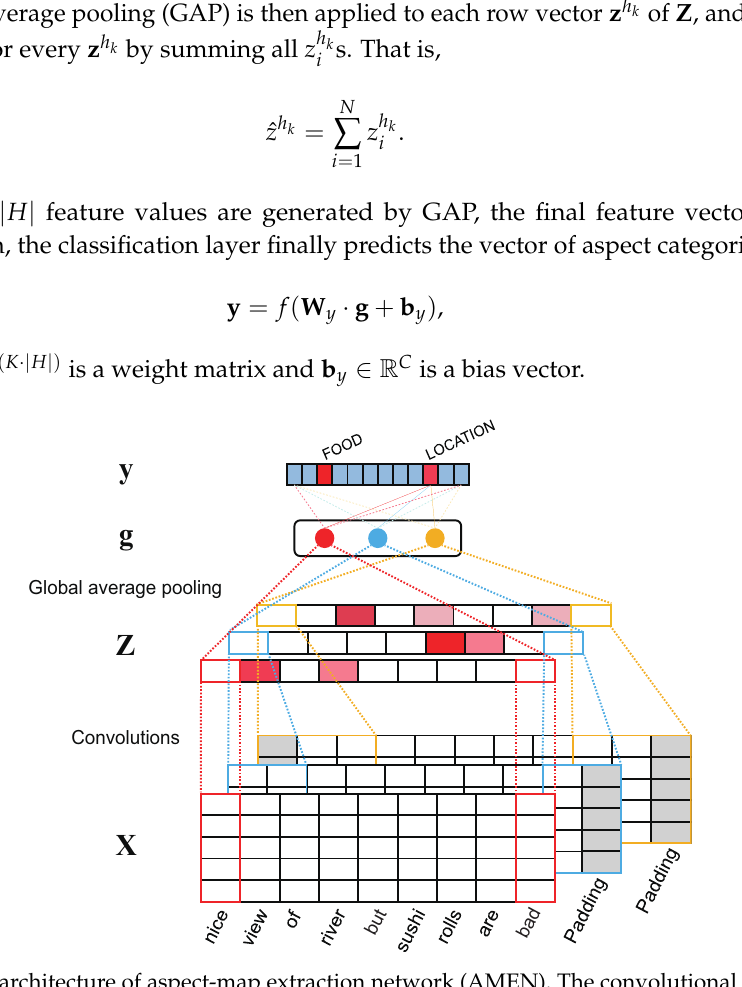
Figure 4. The architecture of aspect-map extraction network (AMEN). The convolutional layer in this figure has three kernels of size h = 1, 2 and